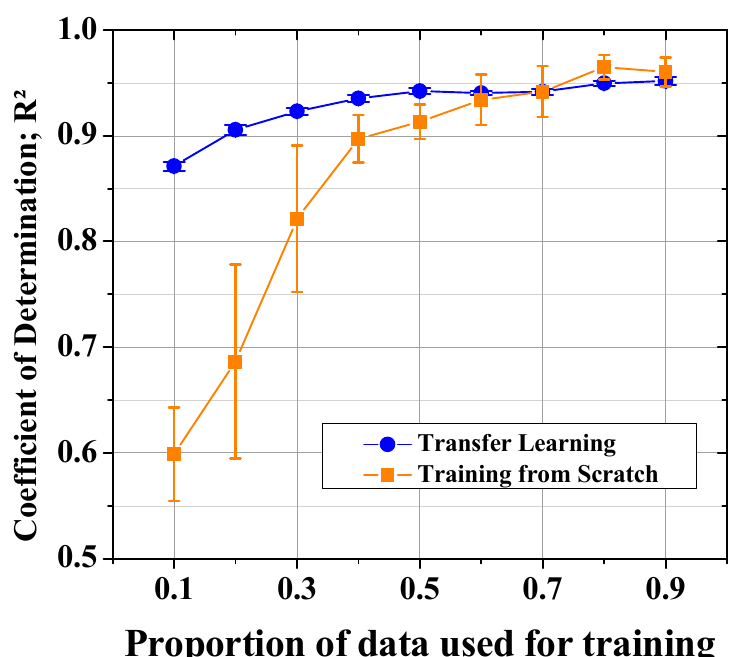
Figure 12. R 2 values of the models with and without transfer learning.